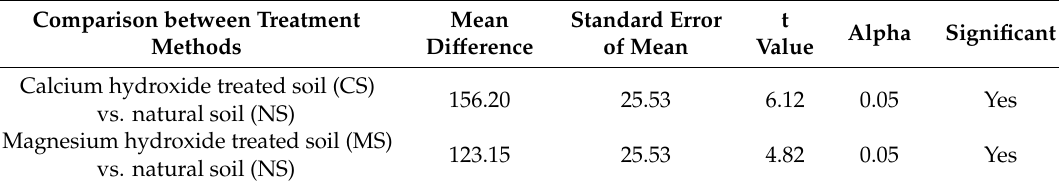
Table 3. Results obtained from Fisher’s least significant difference (LSD) analysis. Comparison between